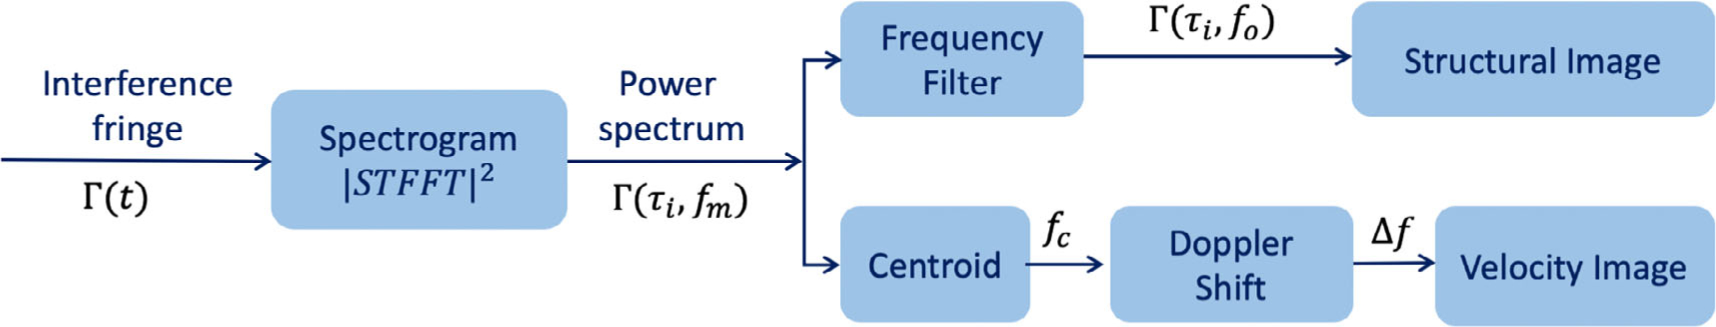
Signal processing for structural and velocity images